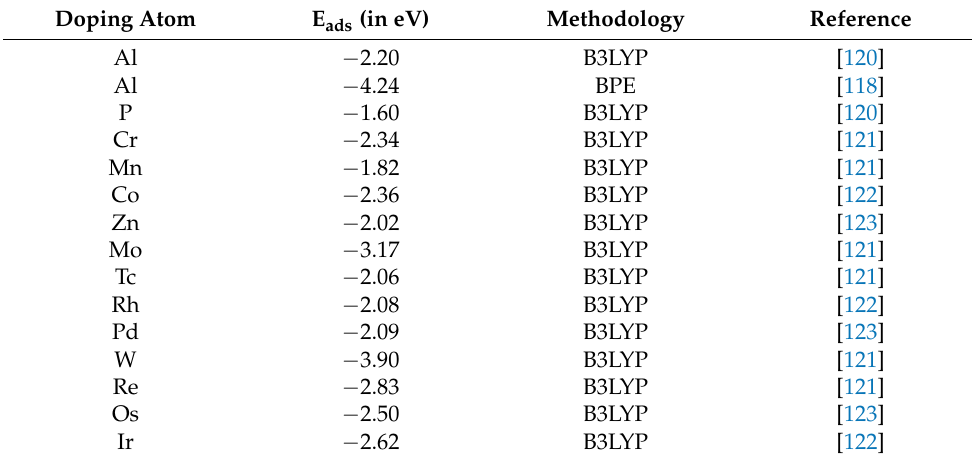
Table 2. NO 2 adsorption on doped